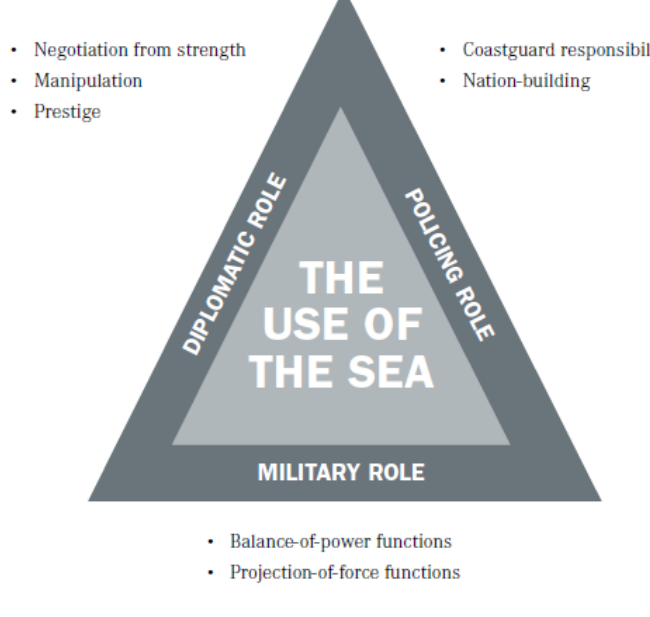
Figure 1. Ken booth trinity